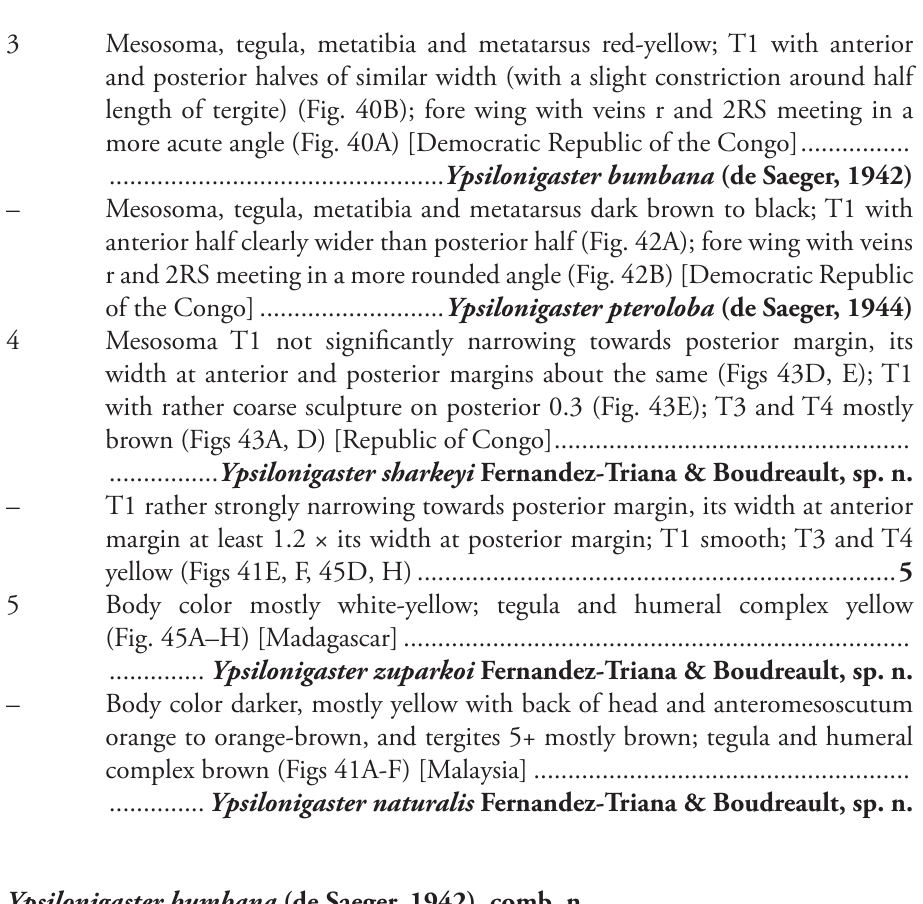
Ypsilonigaster bumbana (de Saeger, 1942), comb. n. Fig. 40 Microgaster bumbana de Saeger, 1942. Original description (de Saeger 1942: 332). Holotype. Female, Democratic Republic of the Congo, RMCA (Musee Royal de l’Afrique Centrale, Tervuren, Belgium). Not examined, but original description checked. Diagnosis. Y. bumbana can be separate from all known species of Ypsilonigaster (except for Y. pteroloba ) based on its darker body color (red-yellow) and infumated wings (all other species are mostly yellow or white-yellow, or have body with striking contrast of four different colors between areas, and all have hyaline wings). Y. bumbana can in turn be differentiated from Y. pteroloba because it has a mostly red-yellow body color, a less constricted T1 and the fore wing veins r and 2RS join in a more acute angle (compare Figs 40A, B with Figs 42A, B). Biology. Host unknown. Distribution. Democratic Republic of the Congo. Molecular data. No molecular data